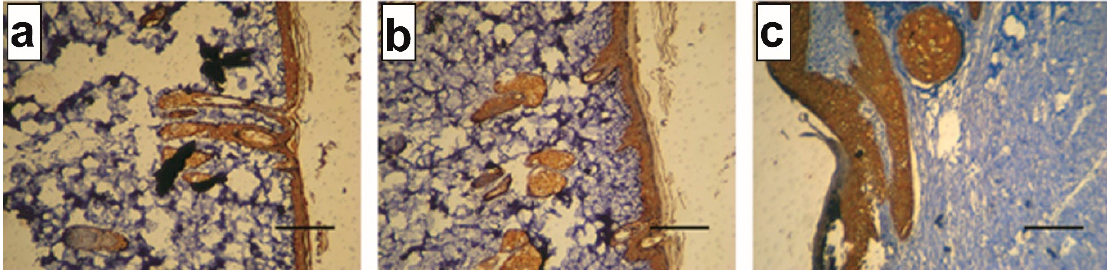
Figure 6. Immunohistochemical analysis against keratin 10 (CK10) at day 14 on ( a ) CPR, ( b ) CP500, and ( c ) CP1000. (Scale bar 50 µm.)